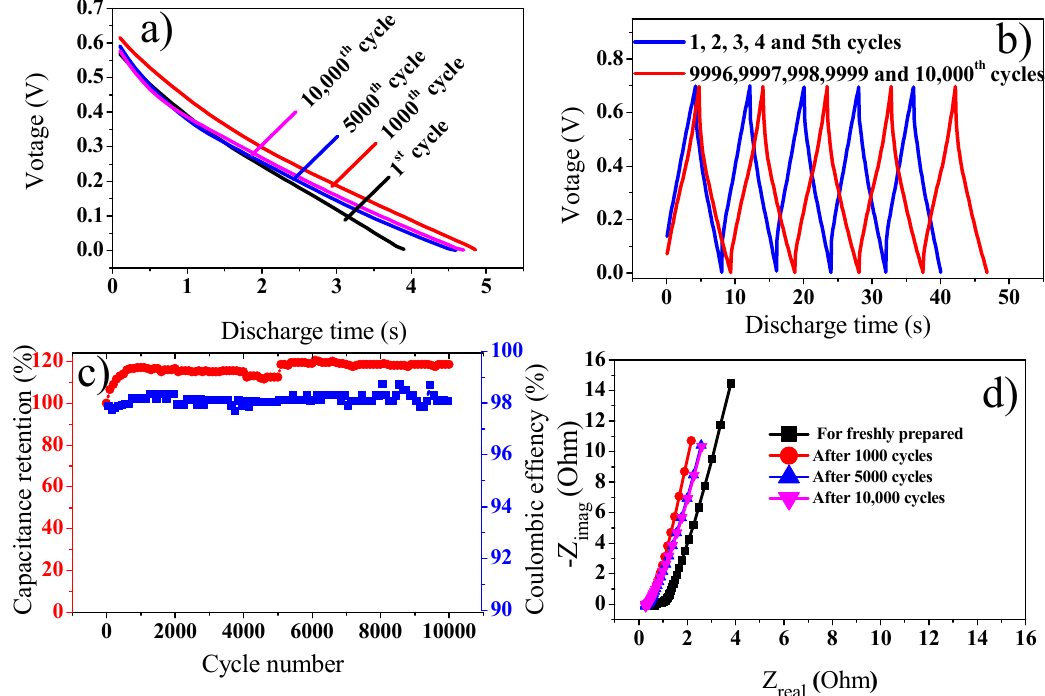
Figure 8. ( a ) Galvanostatic discharge curve for the device at various cycles (1st, 1000th, 5000th and 10,000th). ( b ) Charge discharge behavior of asymmetric device at 1st, 2nd, 3rd, 4th, 5th and 9996th, Figure 8. (a) Galvanostatic discharge curve for the device at various cycles (1 st , 1000 th , 5000 th and 9997th, 9998th, 9999th, and 10,000th cycles. ( c ) Cycling stability and coulombic e ffi ciency of the 10,000 th ). ( b ) Charge discharge behavior of asymmetric device at 1 st , 2 nd , 3 rd , 4 th , 5 th and 9996 th , 9997 th , asymmetric device. ( d ) Nyquist plots recorded for freshly prepared, after 1st, 1000th, 5000th, and 9998 th , 9999 th , and 10,000 th cycles. ( c ) Cycling stability and coulombic efficiency of the asymmetric 10,000th device. ( d ) Nyquist plots recorded for freshly prepared, after 1 st , 1000 th , 5000 th , and 10,000 th cycles.